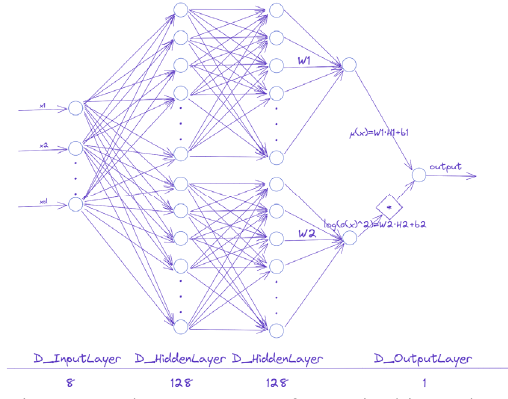
Fig. 1. Topology structure of BNN in this